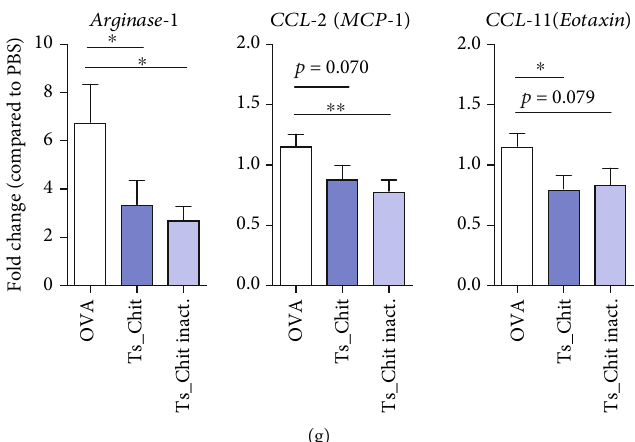
Figure 5: Ts -Chit-mediated e ff ects on lung parenchymal macrophages. (a) Histopathological evaluation of tissue in fl ammation. (b) Histological sections of para ffi n-embedded lung tissues from treated ( Ts -Chit and Ts -Chit inact.), untreated (OVA), and nonsensitized (PBS) controls stained for RELM α (red) and hematoxylin (steel blue) and presented at 400 × magni fi cation. (c) Histological quanti fi cation of interstitial RELM α + cells. (d) Gating strategy and representative plots of RELM α + macrophages (EpCAM - CD11c + CD64 + MHCII + Siglec - ) of lung homogenates from OVA-sensitized and challenged mice with or without Ts